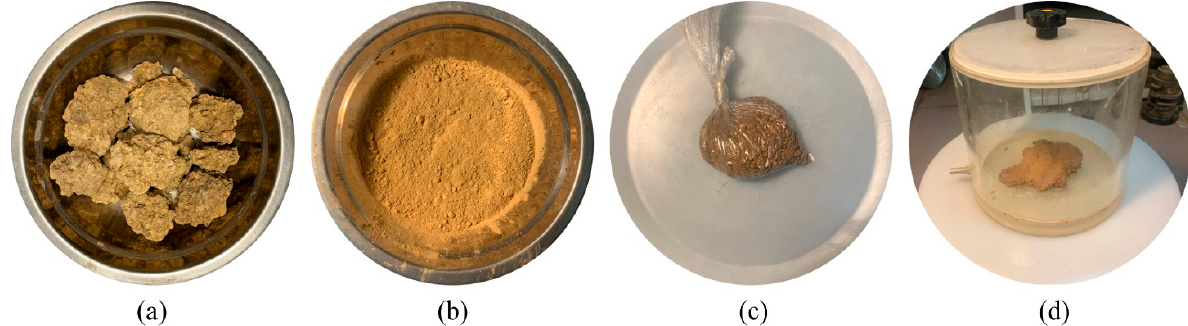
Figure 2. The test procedure: ( a ) initial soil blocks, ( b ) soil after sieving, ( c ) moisture equilibration for 1 h and ( d ) moisture equilibration for 24 h.